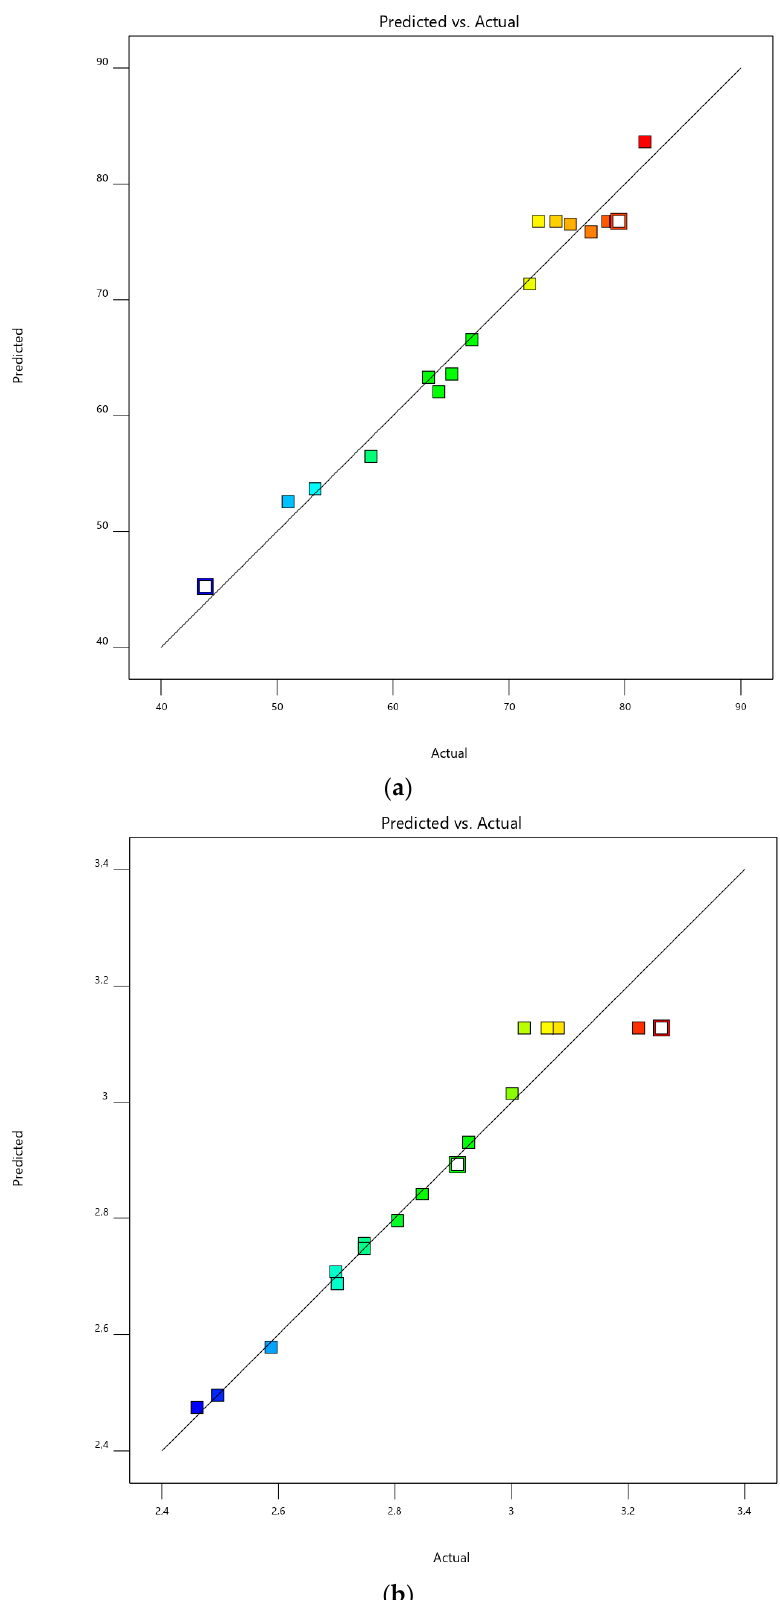
Figure 5. Relationship between the actual and predicted data under optimal conditions (7.8% CaCI 2 , 1.3% alginate, and 26 min) for response EE ( a ) and reponse antioxidant activity ( b